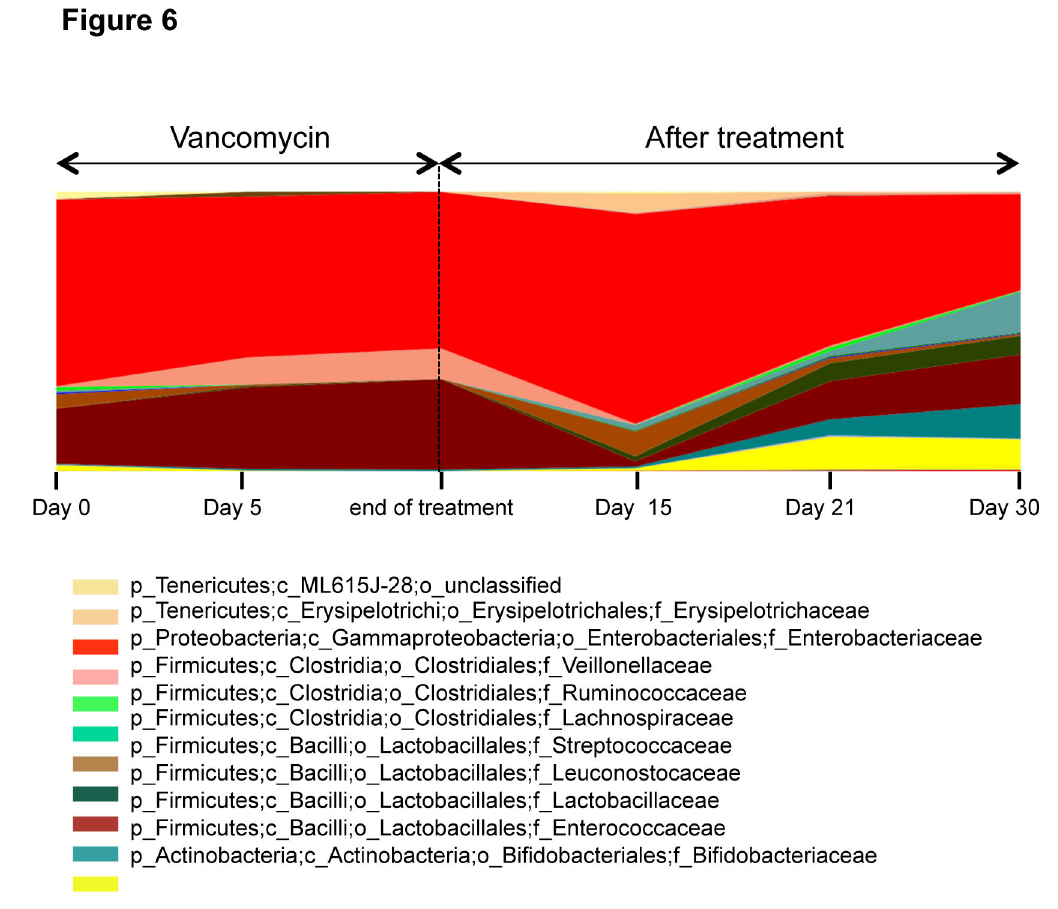
Figure 6. Surveillance of bacterial family relative abundance before, during, and after vancomycin treatment in one patient. Stool samples were collected before (Day 0), during, and after vancomycin treatment at the indicated time points. Changes in the abundance (abundance >0.05%) of major bacterial families are shown at each time